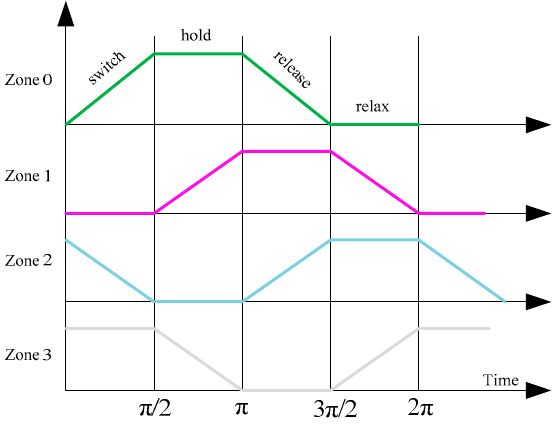
Figure 3. Four distinct QCA clock stages.